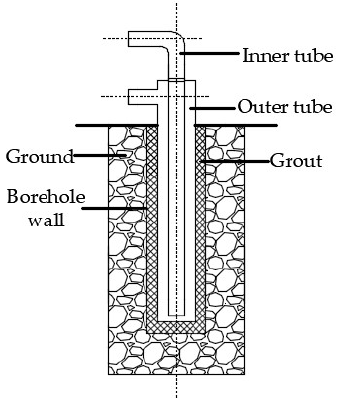
Figure 1. Schematic diagram of the structure of the double-pipe heat exchanger.